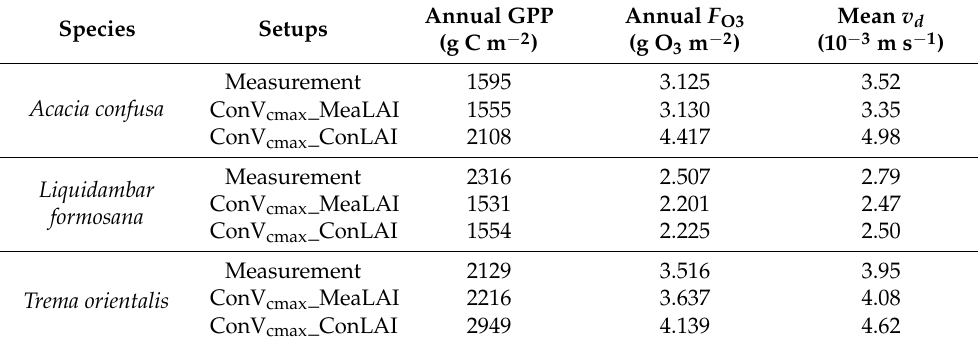
Table 3. Simulated annual gross primary production (GPP), ozone dry deposition flux ( F O3 ), and dry deposition velocity ( v d ) of the three species in Tai Tong in the simulated years. The meter square in the unit refers to land area. Setups include: a ‘Measurement’ setup using the measured V cmax25 and LAI data; one using conventional V c max25 and measured LAI (ConV cmax _MeaLAI); one using conventional V c max25 and conventional LAI (ConV cmax _ConLAI). Monthly time series of simulated results are presented in Figures S2–S10 in the Supplementary Materials.